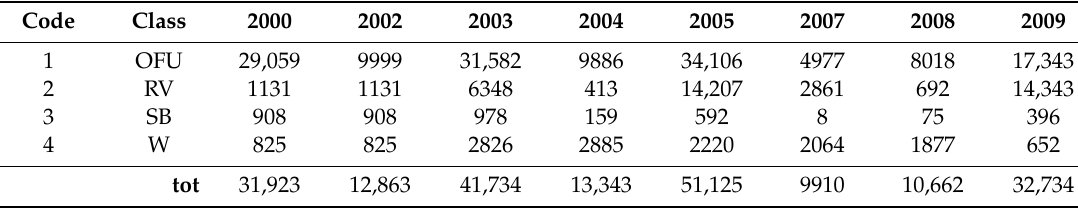
Table 3. Number of reference objects to be used for classification, for each zone and class.